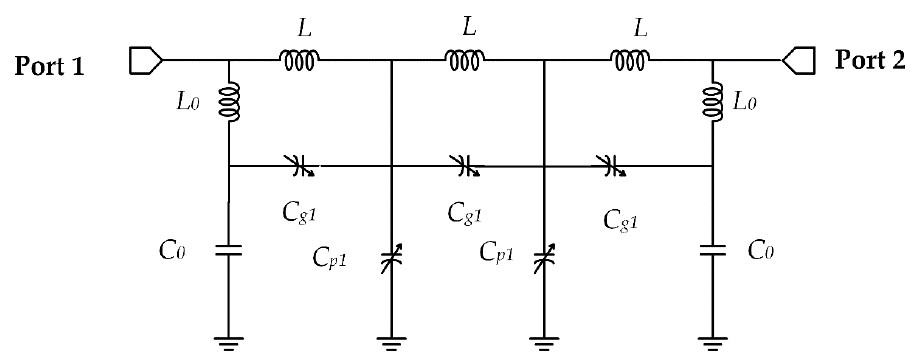
Figure 4. The diagram of the adopted low pass filter at the feeding line. Table 2. Antenna parameters and their values.